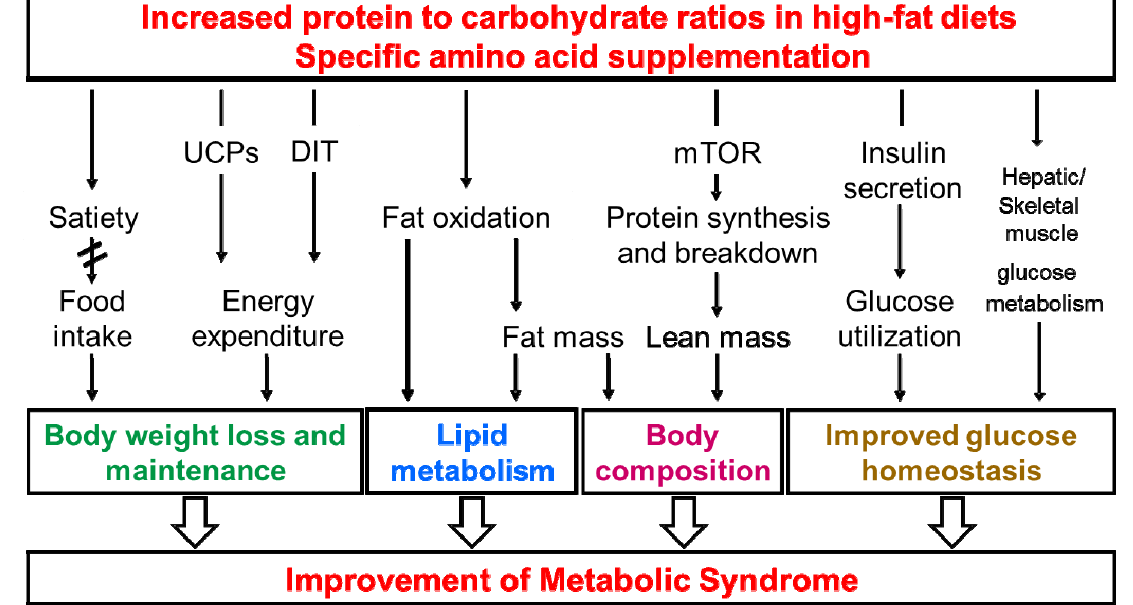
Figure 1. Simplified scheme of possible mechanisms of beneficial effects of dietary protein on the metabolic syndrome. UCP, uncoupling protein; DIT, diet-induced thermogenesis; mTOR, mammalian target of